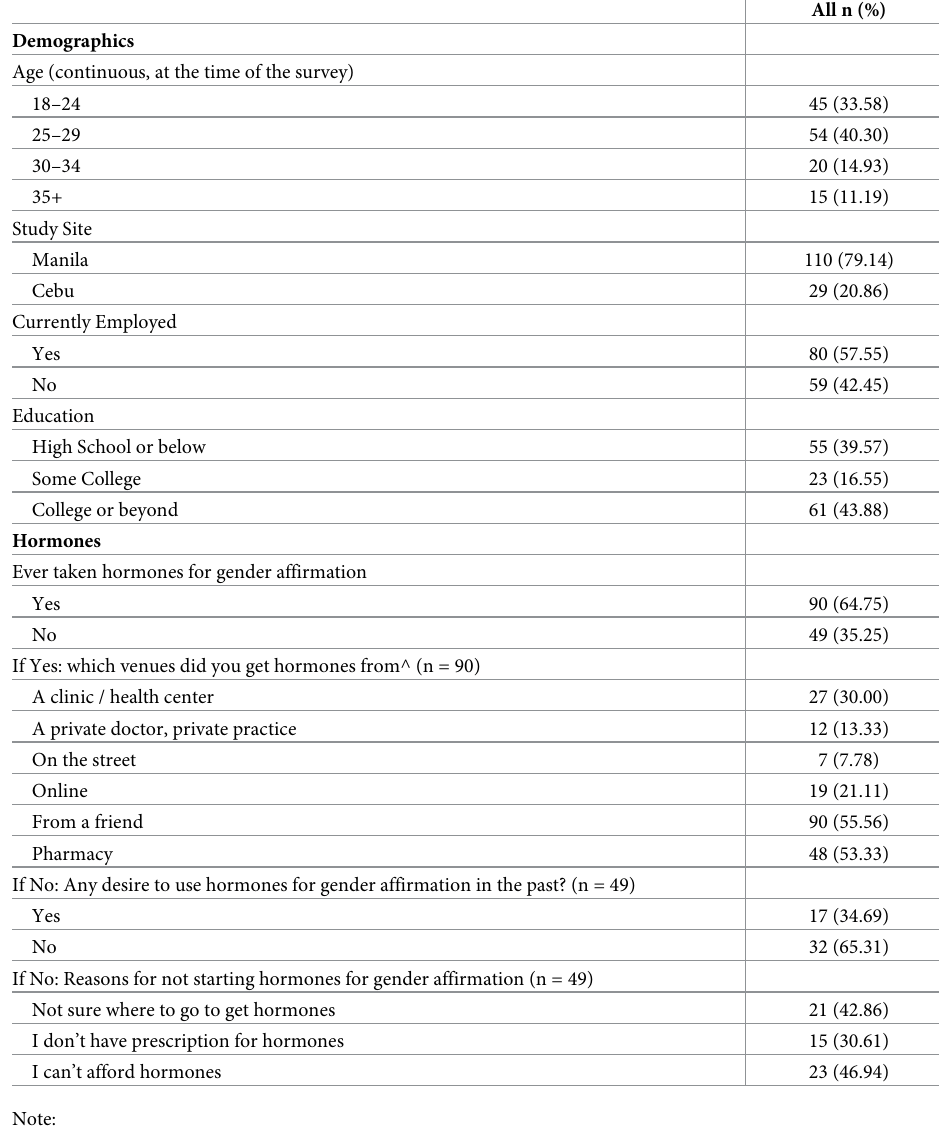
Table 1. Sociodemographic and hormone history(n =